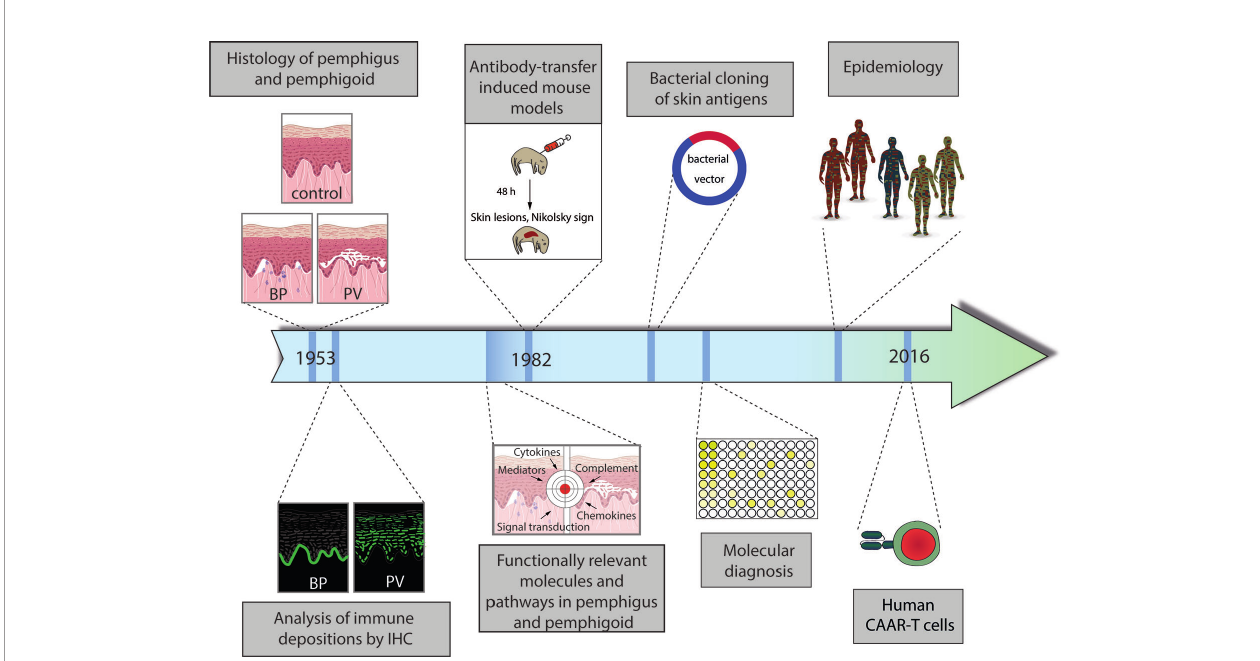
FIGURE 1 | Schematic diagram of the milestones in personalized medicine in pemphigus and pemphigoid. (1) Distinction of pemphigus and pemphigoid based on clinical observation and histology of lesional skin. (2) Identi fi cation of distinct binding patterns of autoantibodies in pemphigus (exempli fi ed by pemphigus vulgaris, PV) and pemphigoid (exempli fi ed by bullous pemphigoid, BP). (3) Proof of the autoimmune pathogenesis of pemphigus and pemphigoid by transfer of patient IgG into mice with the subsequent development of pemphigus. (4) Identi fi cation and cloning of autoantigens. (5) Establishment of the current, molecular-based diagnostics of pemphigus and pemphigoid. (6) Identi fi cation of unique subgroups by careful clinical observation and epidemiology. (6) Individualized treatment by the use of chimeric autoantigen receptor (CAAR) T cells. More details are given in the